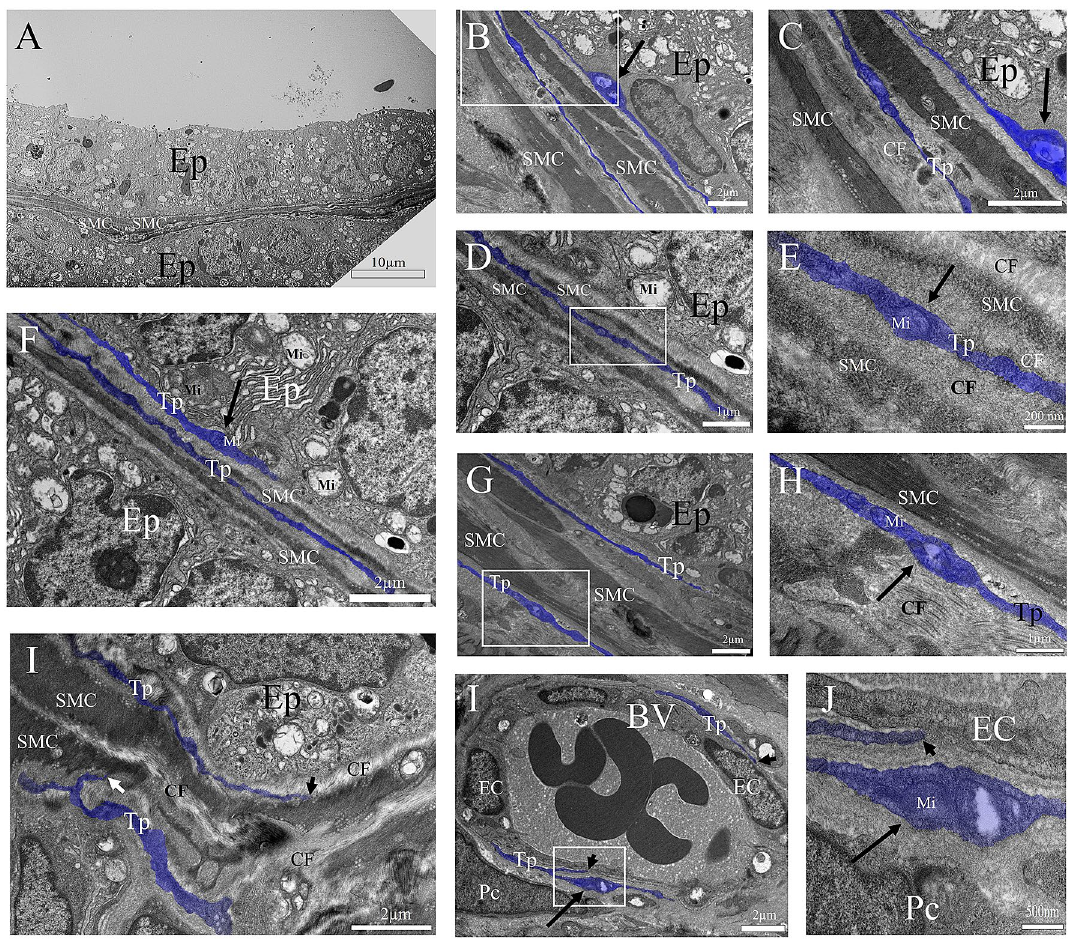
cells. Ep (Prostate epithelium / epithelial cells), SMC (Smooth muscle cells), blue (telocytes), Inserts (Telocyte details), Arrow (podoms), CF (collagen fibrils), Tp (Telopode), Mi (Mitochondria), SMC (Smooth muscle cells), arrowhead (Cell junctions), EC (Endothelial cell), Pc